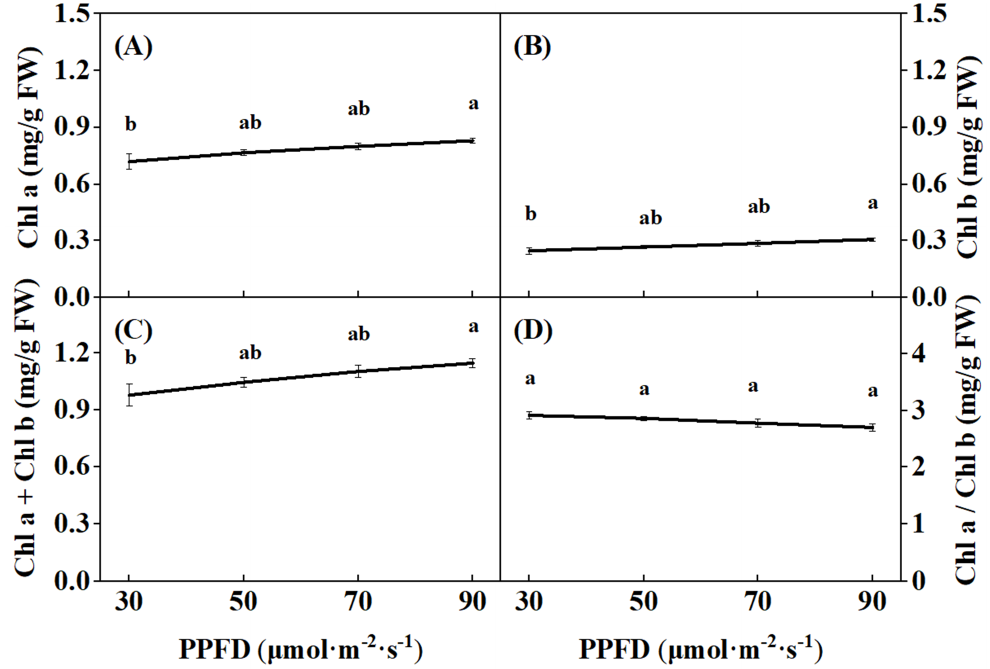
Figure 4. Effects of different light intensity on the contents of Chl a ( A ), Chl b ( B ), Chl a + Chl b ( C ), and Chl a / Chl b ( D ) in broccoli microgreens. The lowercase letters in all figures represent the significant difference ( p < 0.05). Vertical bars indicate the means ± SE (n = 3).